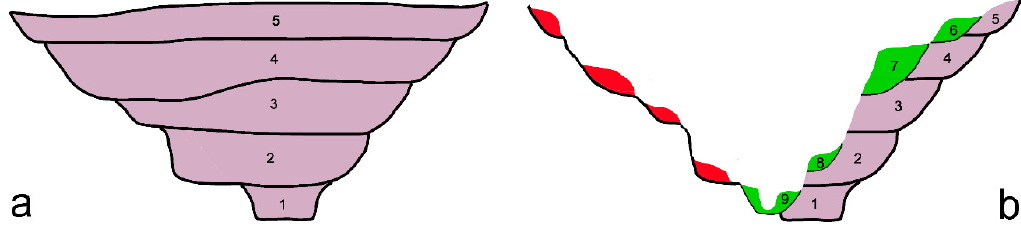
Figure 12. ( a ) A theoretical flument stack: 1 the oldest, 5 the youngest flument of the stack. ( b ) The stack has been eroded forming a flument flight (green) with four cut-in terraces (6–9) and leaving behind only remnants of the stack 1–5 (dark violet). On the left side of the valley occur isolated, so-called lost fluments (red), which are obviously unpaired, and the assignment of which is not clear, whether they belong to the stack (violet) or to the cut-in terrace flight (green) or represent additional